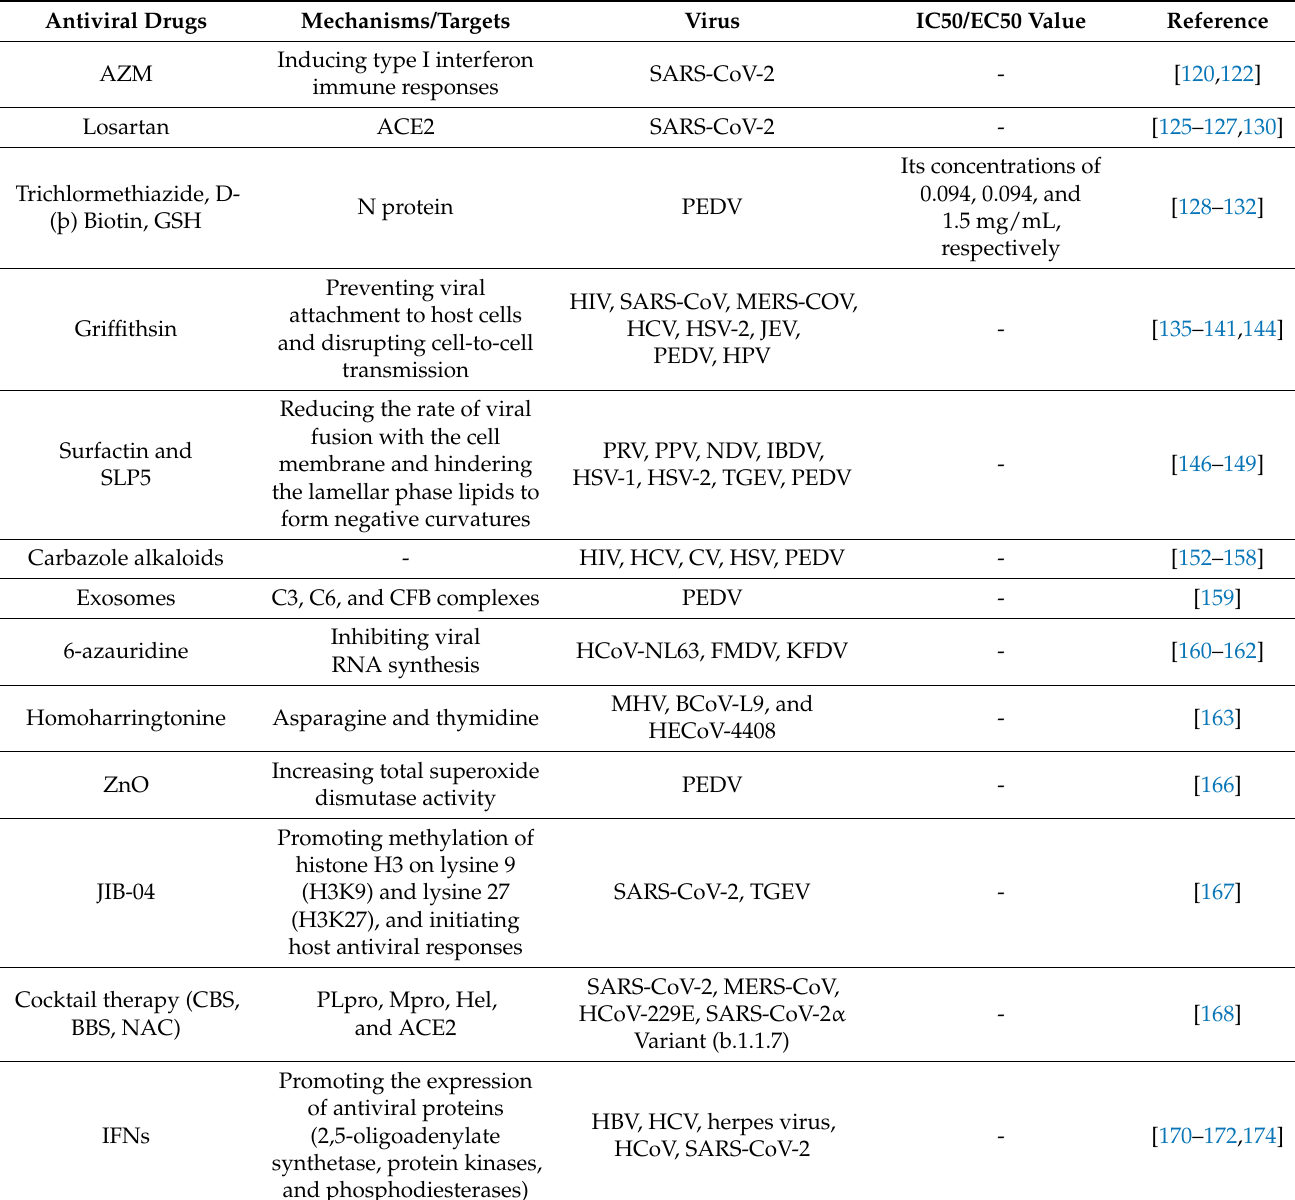
Table 6. Potential antiviral drugs and the antiviral